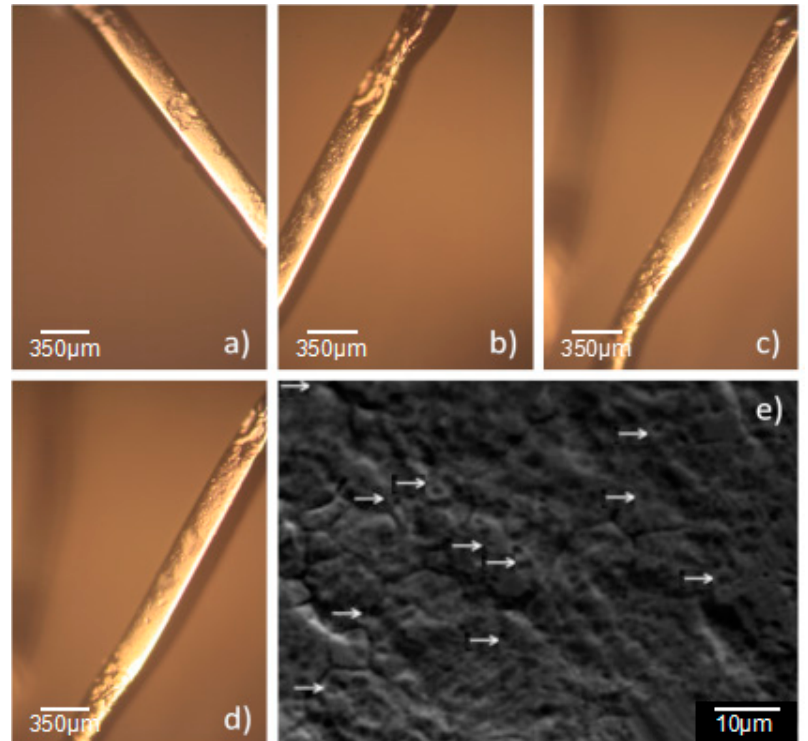
Figure 3. ( a – d ) Light microscopy images recorded for sample. ( a ) P1; ( b ) P7; ( c ) P10; ( d ) P11); ( e ) scanning electron microscopy image of samples P11 morphology with pitting corroded areas marked by arrows.